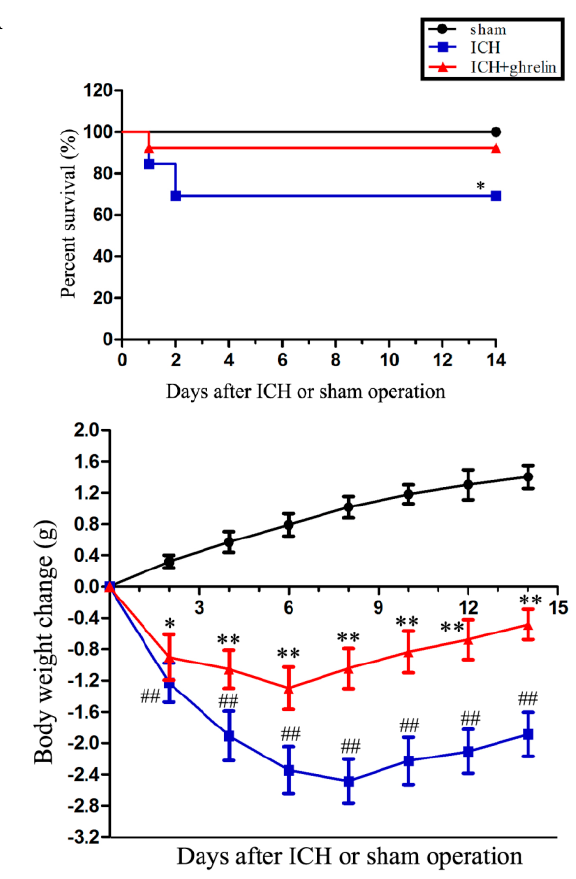
Figure 6. Ghrelin improved the survival rate and reduced body weight loss after ICH. ( A ) The survival rate was reduced following ICH induction without ghrelin administration (ICH, n = 26) compared with the sham group (sham, n = 13). The administration of ghrelin (ICH + ghrelin, n = 26) significantly reduced ICH-induced mortality. There was no significant difference between the sham group and the ICH + ghrelin group; ( B ) The body weight was significantly lower in the ICH mice than that in the sham mice; however, ghrelin significantly attenuated ICH-induced weight loss starting from day 2 to day 14; n = 9. The values are the mean ± SD, ## p < 0.01 vs. sham group; * p < 0.05 vs. ICH group; ** p < 0.01 vs. ICH group.